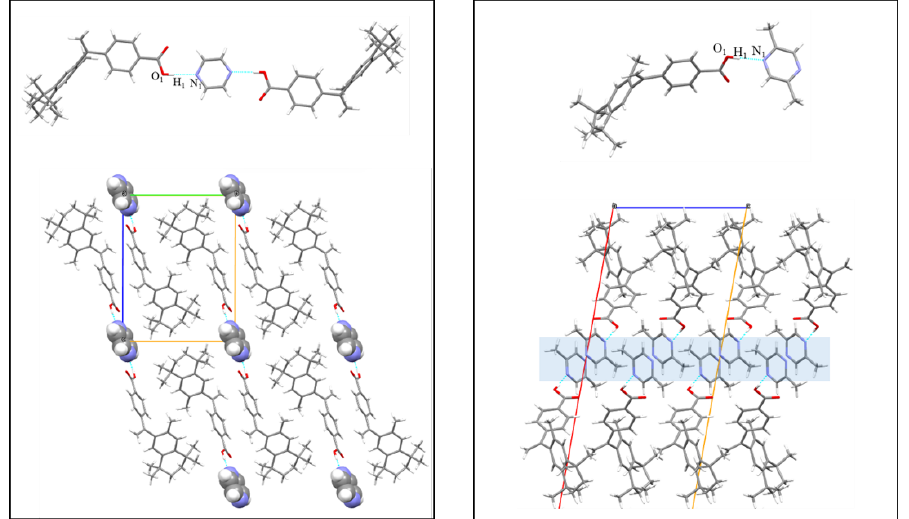
Figure 9. Packing modes of BEX-pyrazine ( left ) and BEX-2,5-dimethylpyrazine ( right ).